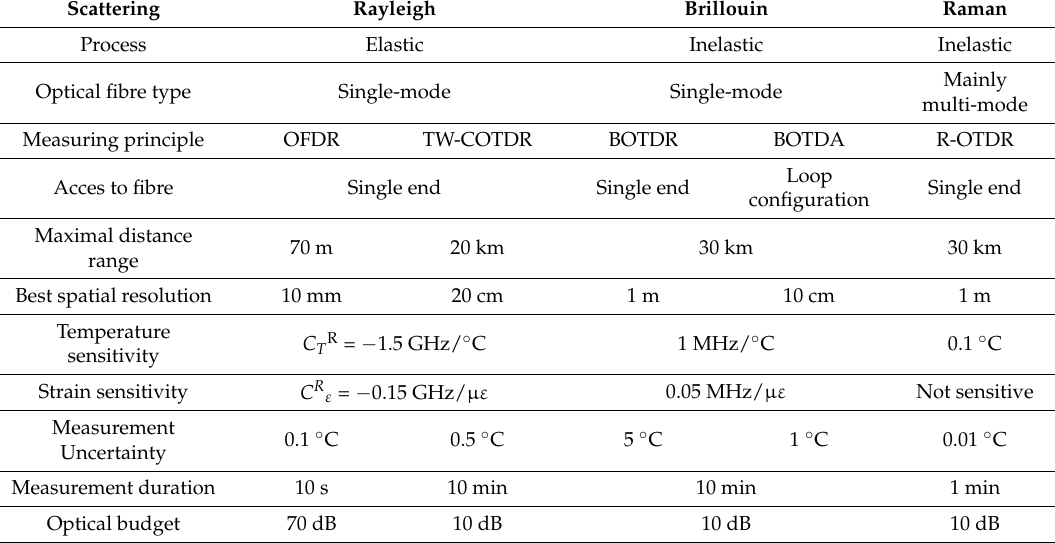
Table 2. Typical performances of distributed temperature and sensing systems based on Rayleigh, Brillouin and Raman scatterings in optical